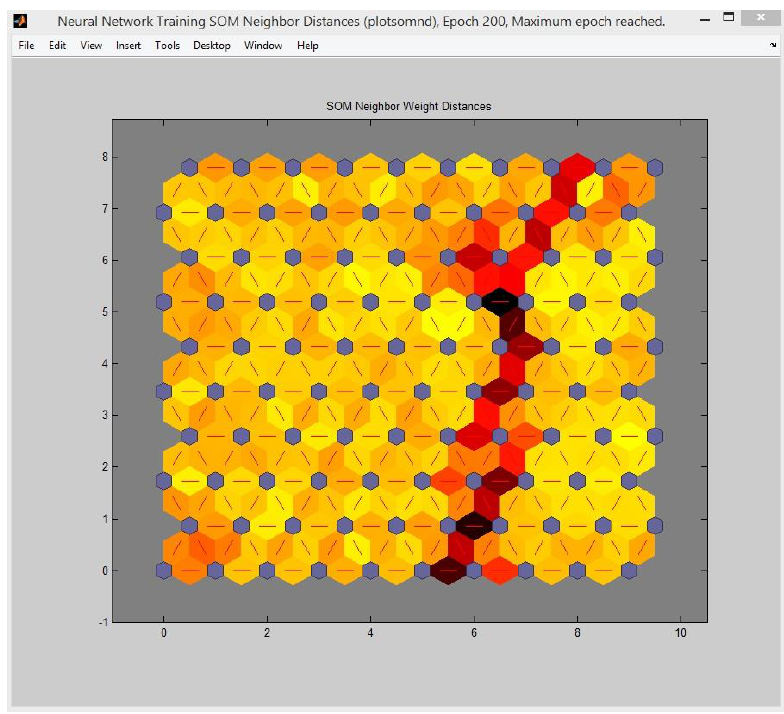
Figure 12. SOM neighbor distance plot using the GUI toolbox in MATLAB.